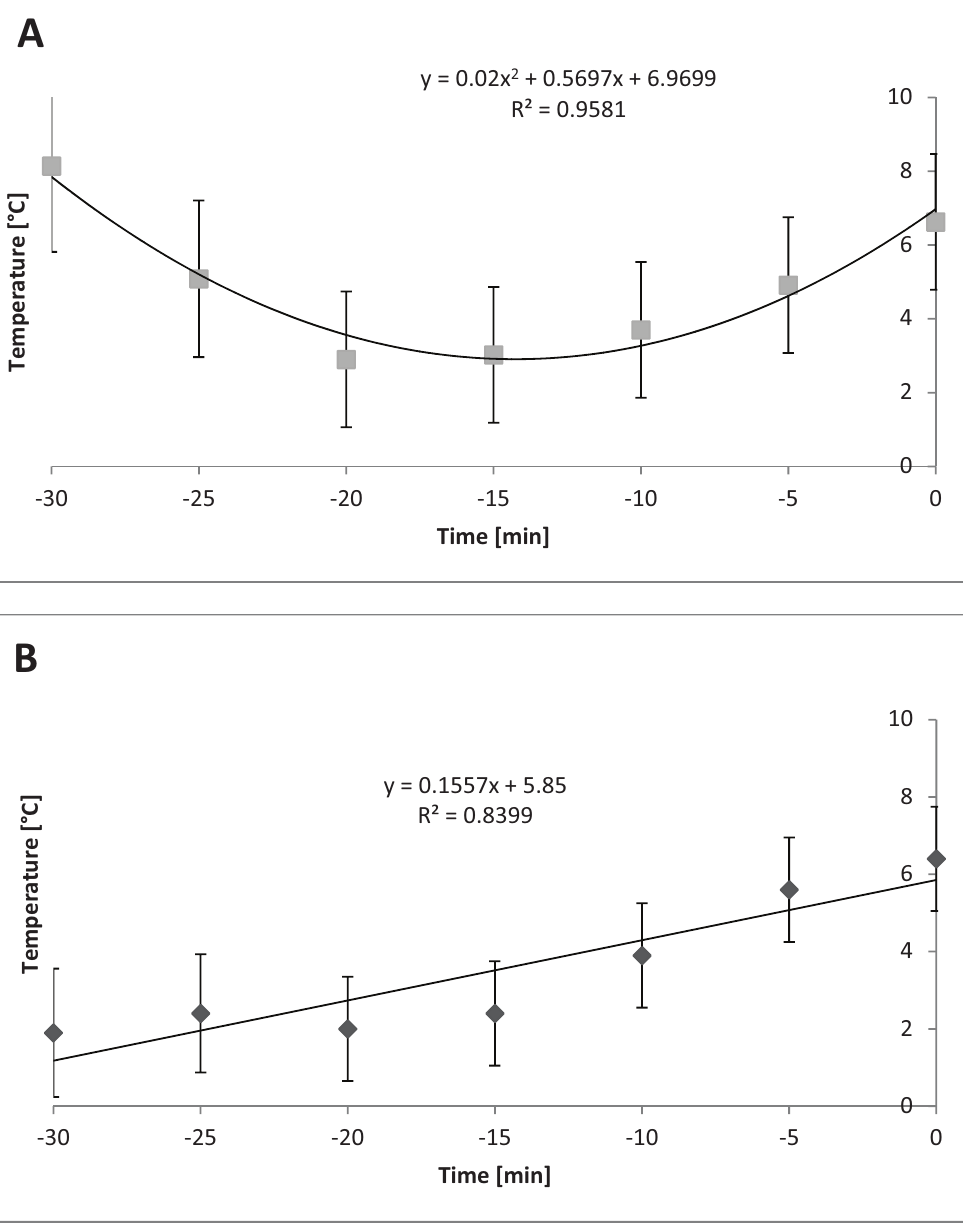
y = 0.02x 2 + 0.5697x + 6.9699 R² =